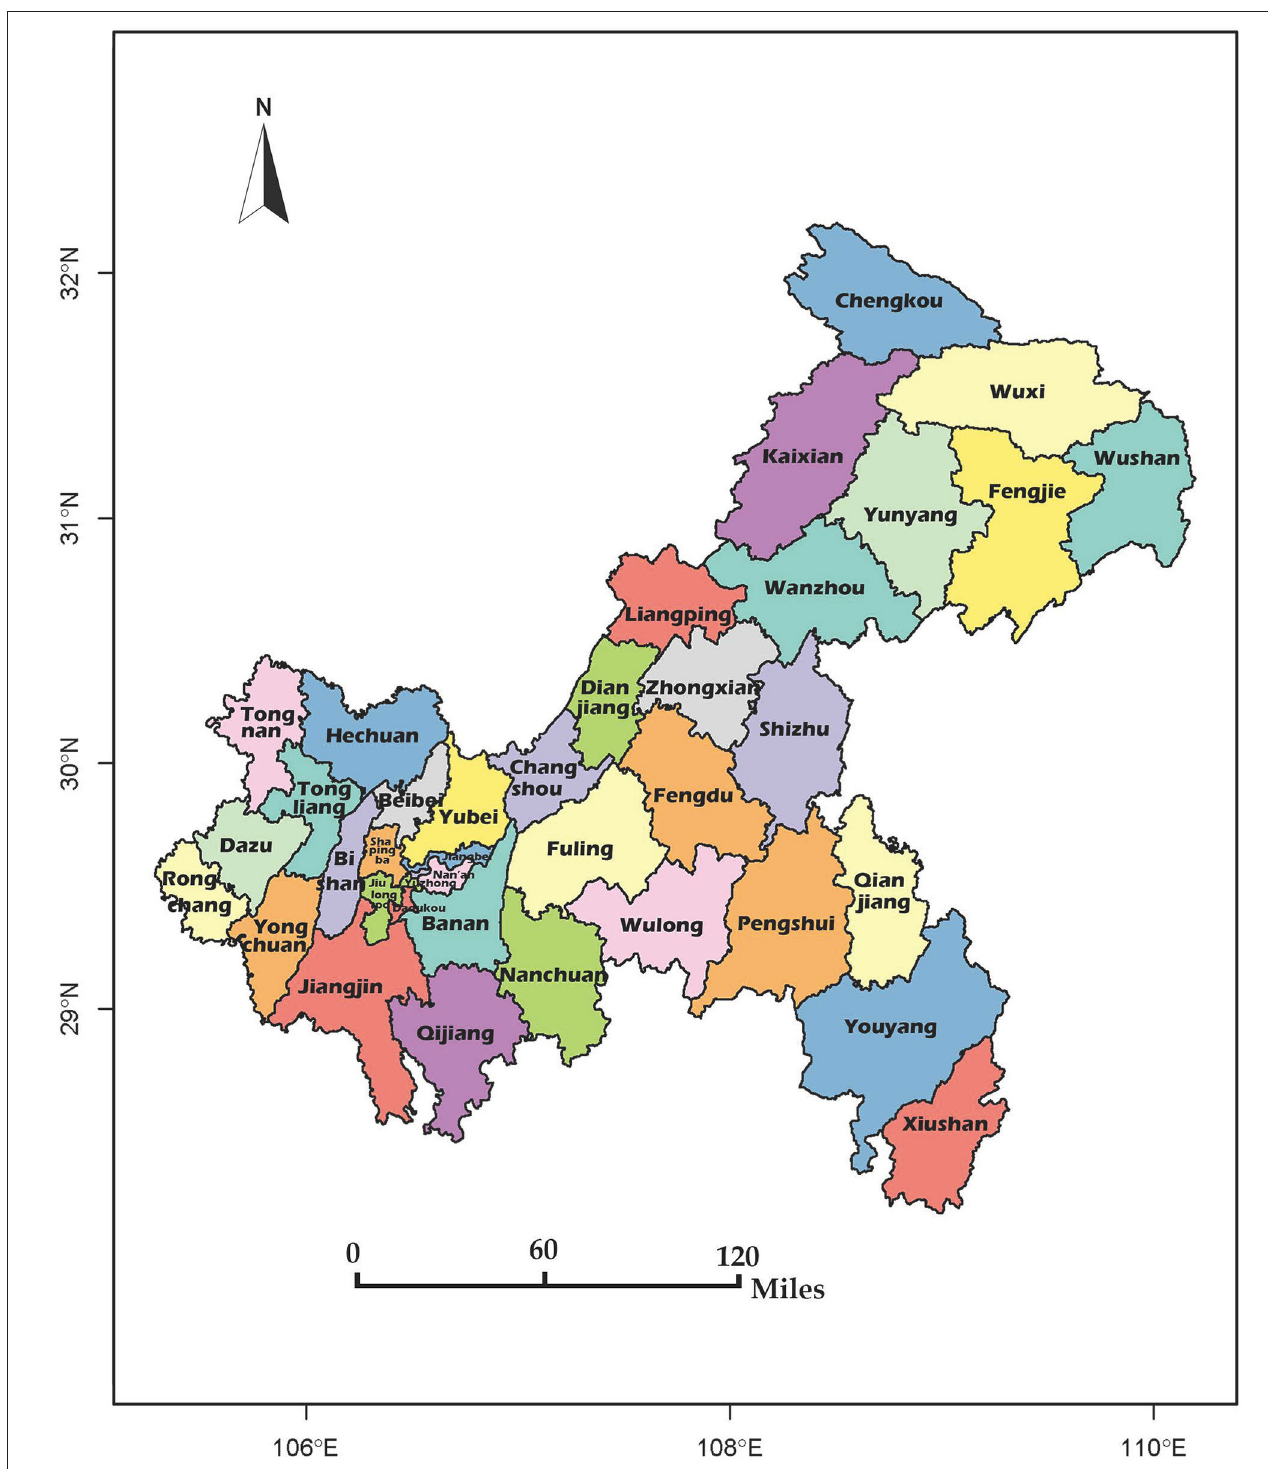
FIGURE 1 | Map showing the geographical location of Chongqing and the districts in this city. also utilized spatial autocorrelation analysis, with one district as a geographic unit. Global and local Moran’s I were applied to identify the significant spatial autocorrelation regions of